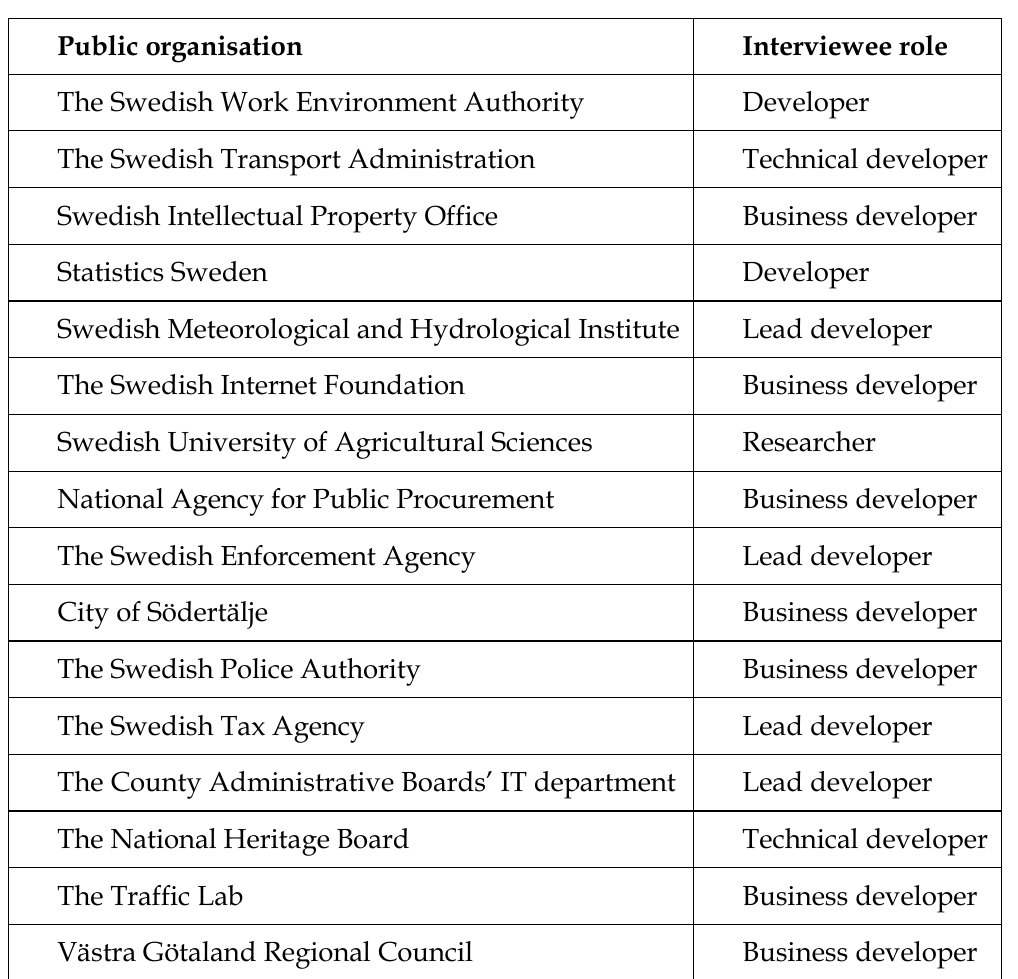
Table 1: Public Organizations with Interviewee